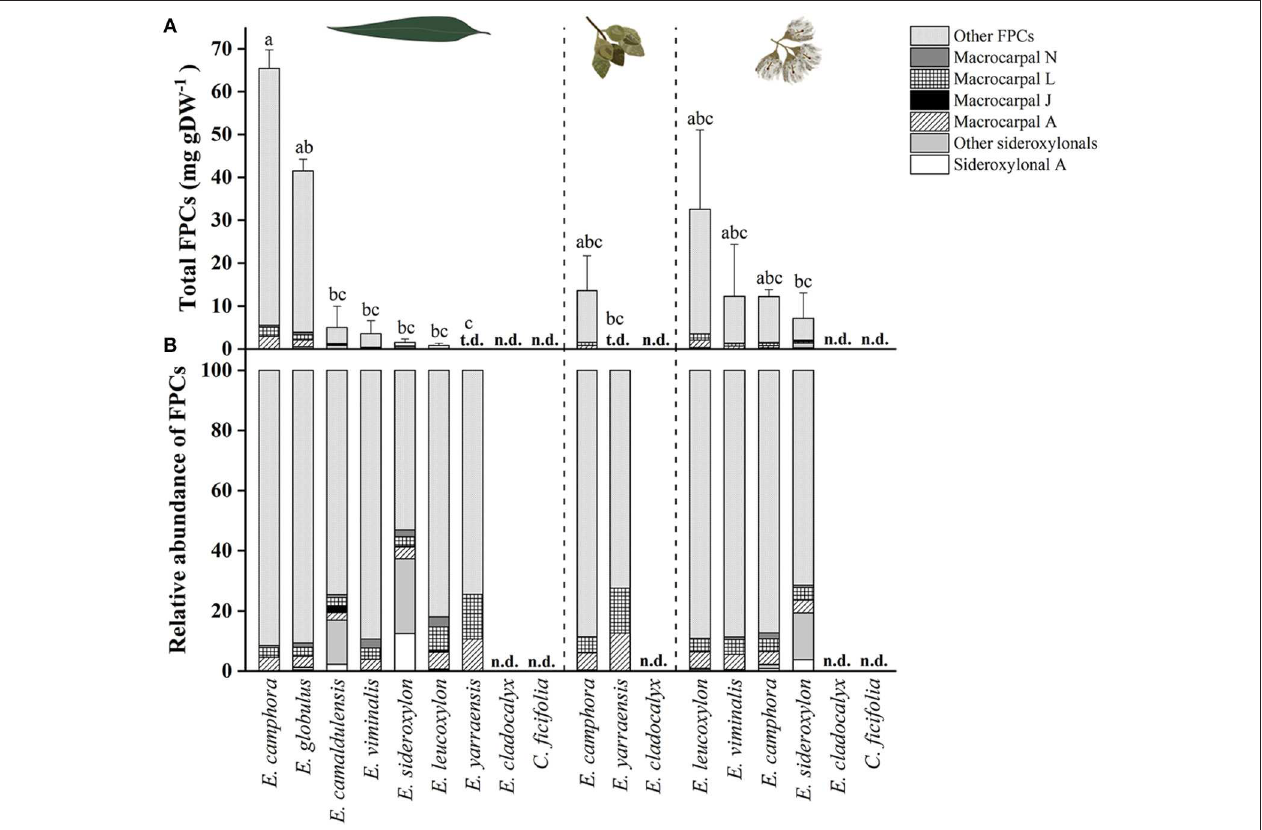
FIGURE 4 | (A) Total FPCs concentration in leaves, flower buds and flowers of different eucalypt species. Bars represent mean ± standard error. Small letters represent statistical differences according to one-way ANOVA p < 0.050. (B) Relative FPCs concentration as percentage in respective tissues. t.d., traces detected; n.d., not